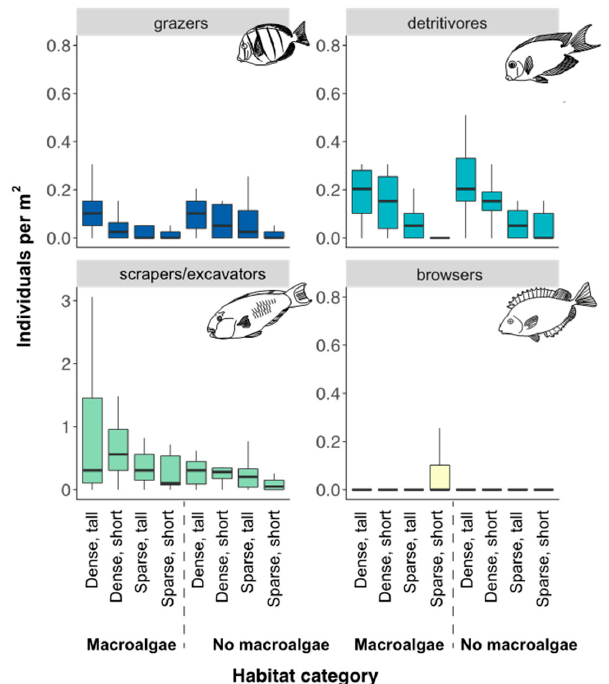
Figure 4. Densities of functional groups of herbivorous fish (grazers, browsers, scrapers / excavators,